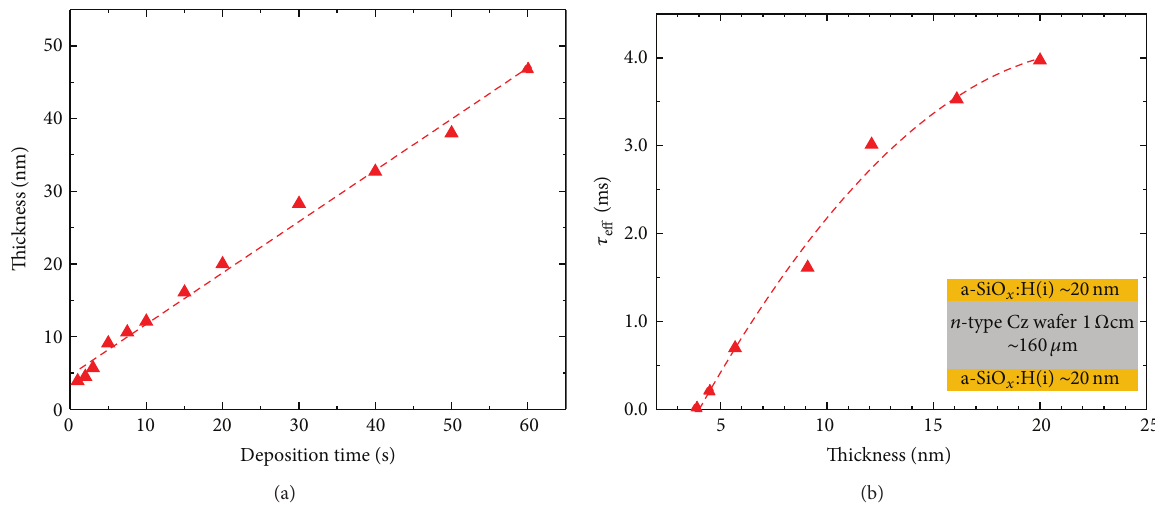
Figure 2: (a) a-SiO 𝑥 :H(i) thin film thickness as a function of deposition time; (b) 𝜏 shows the sample structure used in lifetime determination. The lines are guides for the eye. A constant deposition rate is observed for all samples in this series. Lifetime saturation is observed after 20nm film deposition.